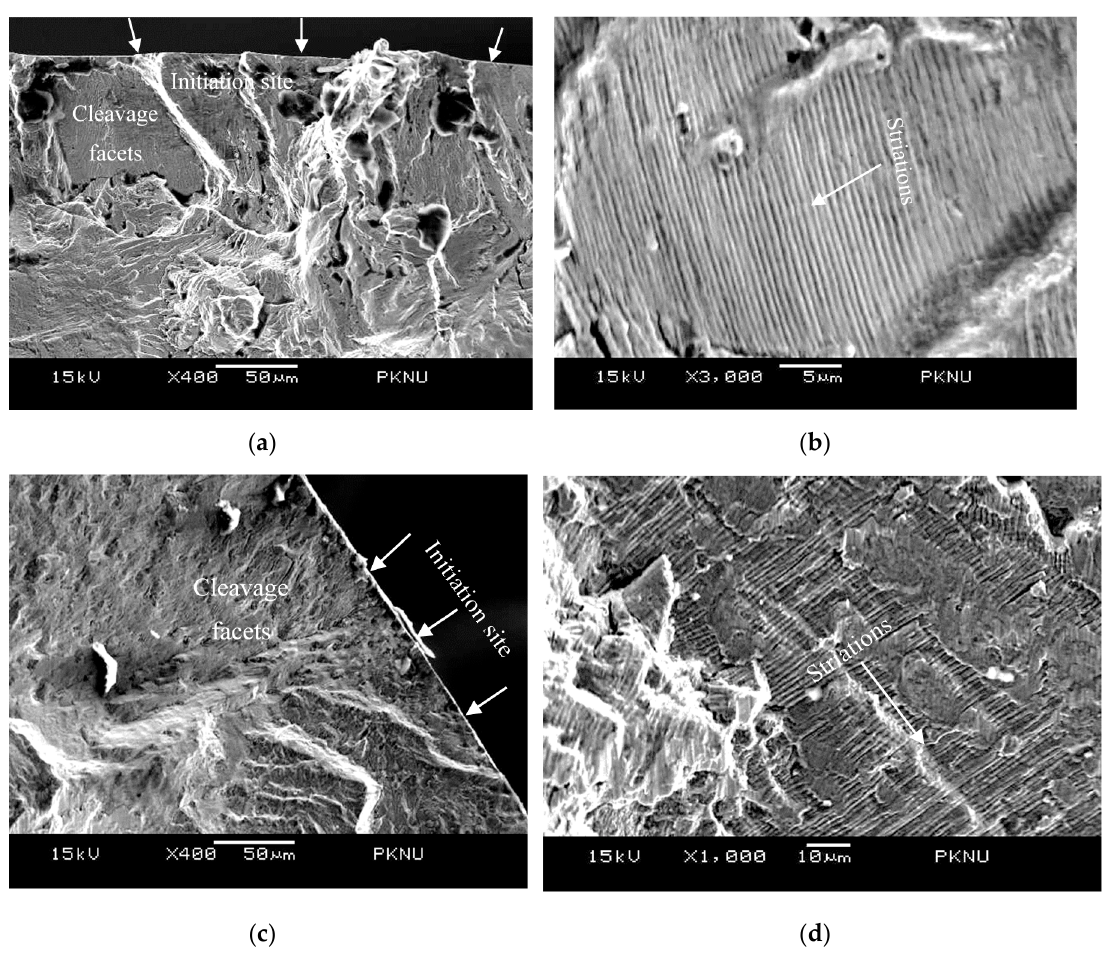
Figure 11. Typical SEM micrographs of the fractured surface for Alloy 617 weldments at 0.6% total strain range: ( a , b ) Room temperature; ( c , d ) 800 °C condition.